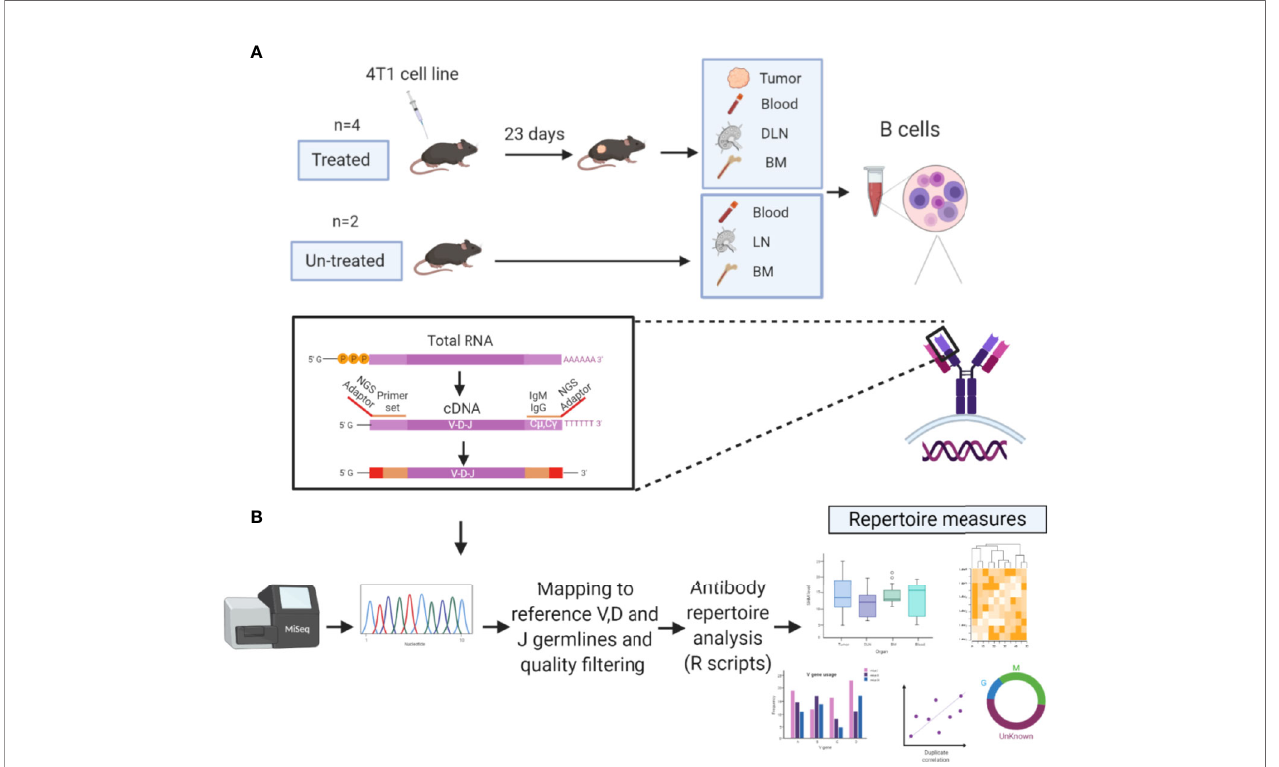
FIGURE 1 | Experimental and computational platform for antibody repertoire analysis of TIL-Bs. (A) BALB/c female mice (6 – 8 weeks old, n = 4) were inoculated with 4T1 tumor cells into the mammary fat pad. On day 23, mice were sacri fi ced, and B cells (IgM/IgG/CD138+) were isolated from four tissue types: tumors, bone marrow, draining lymph nodes (DLNs), and peripheral blood. Recovered mRNA was used as a template to generate NGS libraries. The same experimental pipeline was applied to naïve mice (n = 2) as the control. (B) NGS libraries were sequenced using the Illumina MiSeq 2x300 platform, and the resultant paired-end antibody V H sequences were assembled and aligned using MiXCR (34). V H sequences were then fi ltered and high-quality V H sequence datasets were used to generate antibody repertoire measures (developed in R) of TIL-Bs and B cells from other